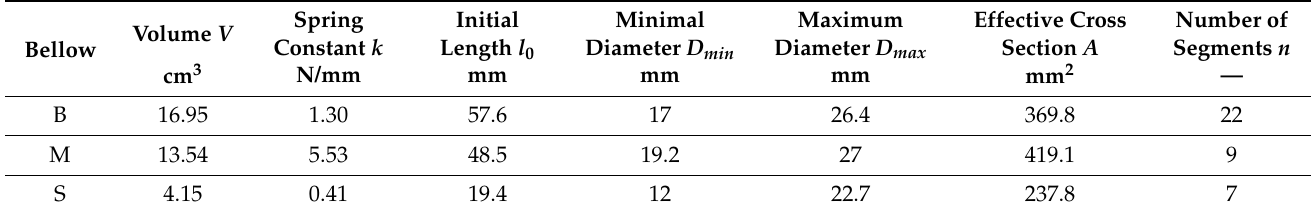
Table 2. Parameters of bellows